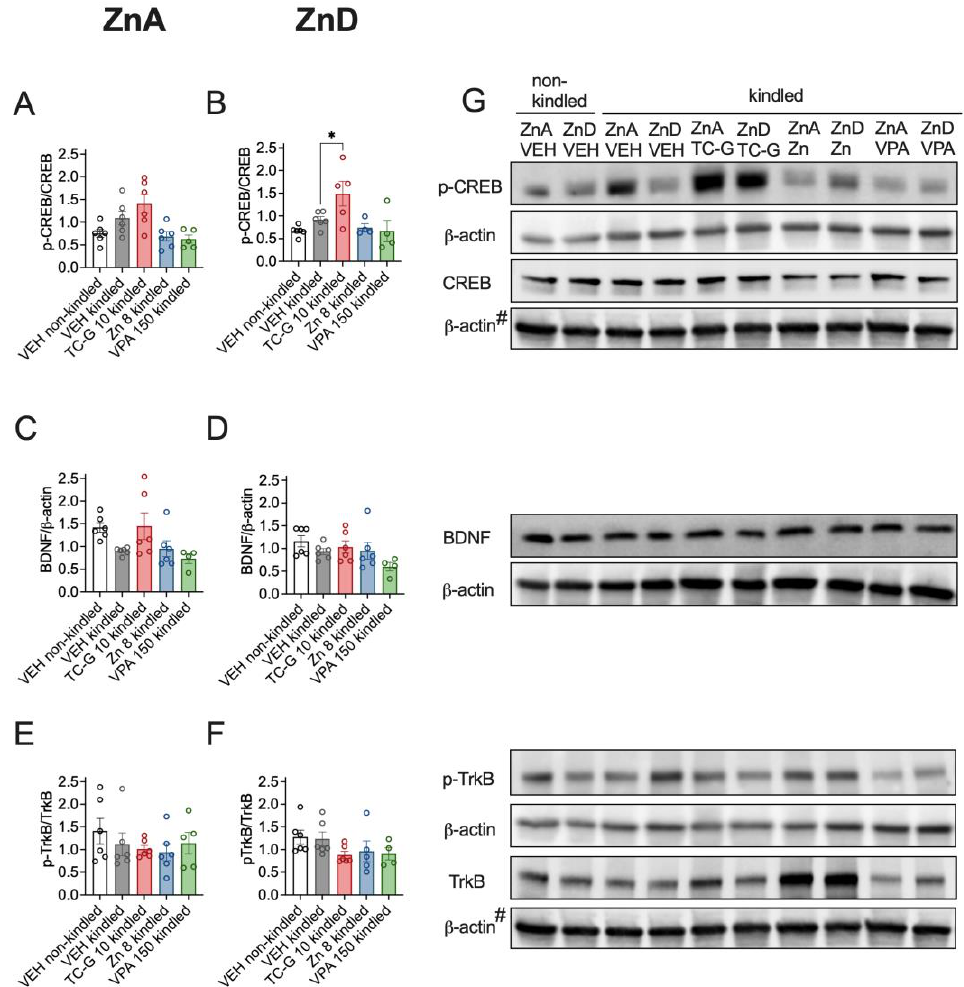
Figure 7. Chronic effects of TC-G 1008 (TC-G) (10 mg/kg), ZnCl 2 (8 mg Zn/kg) or VPA (150 mg/kg) and PTZ-kindling model of epilepsy on the relative expression of proteins: p-CREB, CREB, BDNF, p-TrkB and TrkB in the hippocampi of mice fed the ZnA or ZnD diet. Hippocampal samples were obtained 24 h after the last injection of PTZ. ( A – F ) Data are expressed as means ± SEM of p-CREB/CREB or BDNF/ β -actin or p-TrkB/TrkB ratio. They were analyzed by one-way ANOVA and the Dunnett’s multiple comparison test. n = 4 – 6 in each group. Statistical details: ( A ) F(4,24) = 5.636, p = 0.0024, ( B ) F(4,20) = 4.883, p = 0.0065, ( C ) F(4,23) = 3246, p = 0.0299, ( D ) F(4,23) = 1998, p = 0.1284, ( E ) F(4,24) = 0.6798, p = 0.6127, ( F ) F(4,22) = 1.547, p = 0.2236 (A-F one-way ANOVA). * p < 0.05 vs. VEH kindled group (Dunnett’s multiple comparison test). ( G ) Representative blots of p-CREB (Ser 133), CREB (~46 kDa), BDNF (~14 kDa), p-TrkB (Tyr 816), TrkB (~140 kDa), and β -actin (~42 kDa) in the hippocampi of mice. # CREB and TrkB come from the same blot, thus sharing the corresponding β -actin